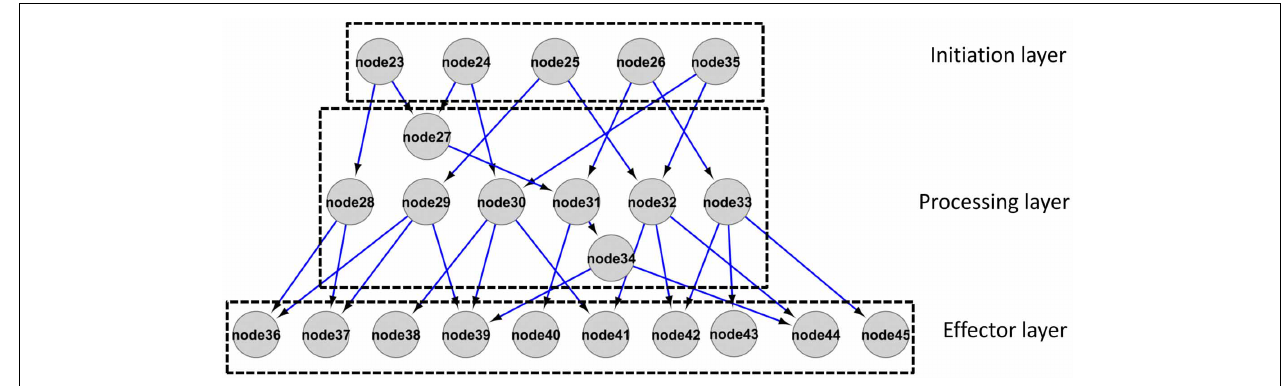
FIGURE 5 | Schematic representation of a network architecture with broadening scope (“information dissemination topology”) as presented from the current dataset in Files S3 and